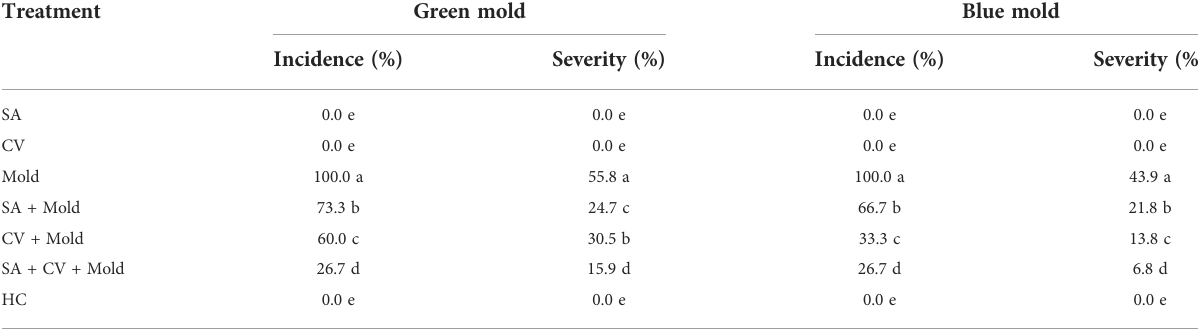
TABLE 2 Effect of SA and C. verum on disease incidence and severity of green and blue mold.